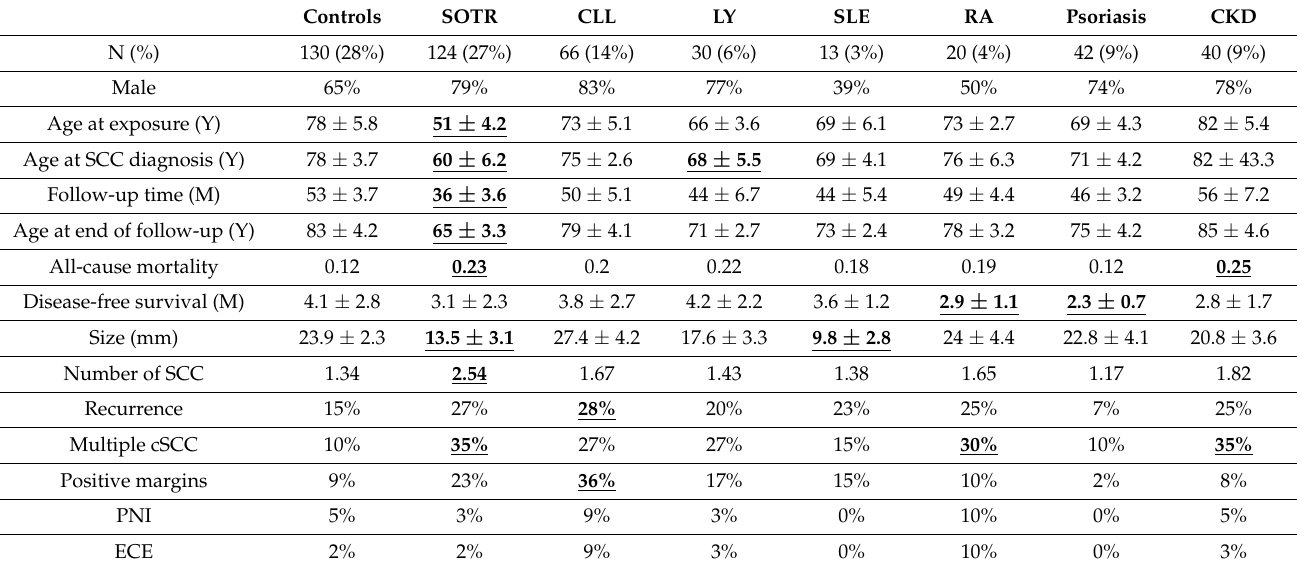
Table 1. Characteristics of the different immunosuppression groups and the immunocompetent controls.